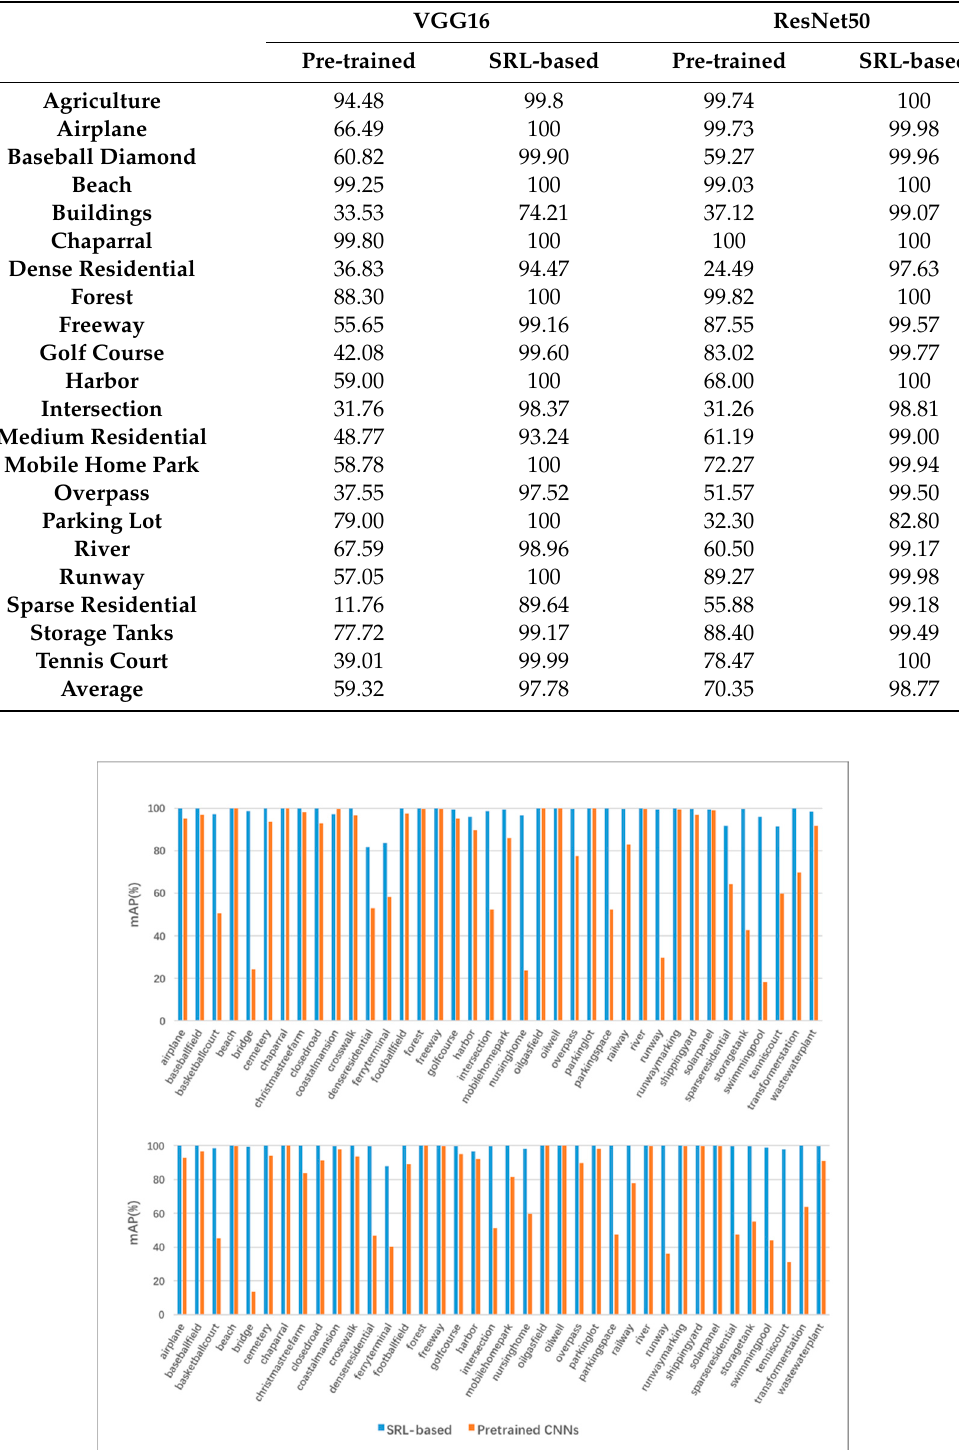
Table 5. Evaluation of mAP which is performed with VGG16 and ResNet50 on per-class in the UCMD datasets comparing with the pre-trained CNNs.